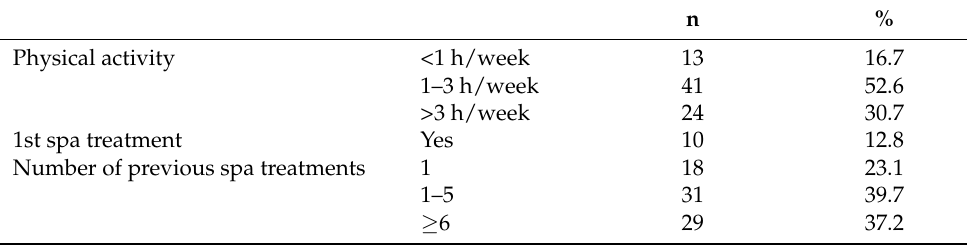
Table 3. Sample characteristics at baseline ( n =